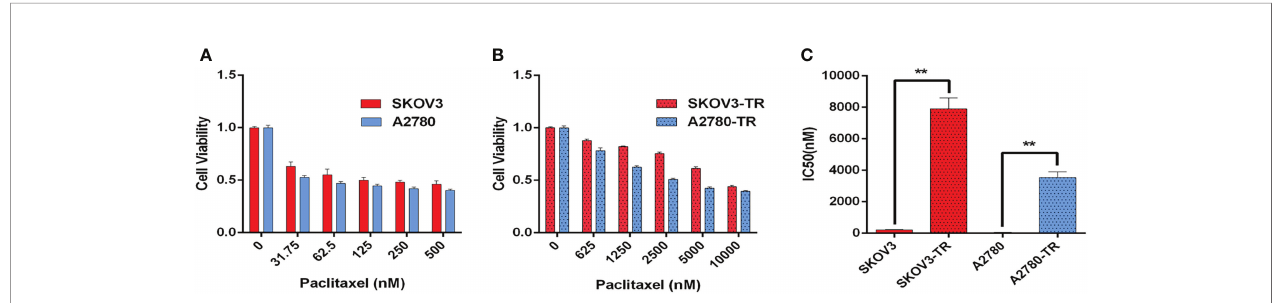
FIGURE 4 | Paclitaxel inhibits ovarian cancer cell viability. (A, B) Viability of paclitaxel-resistant (SKOV3-TR and A2780-TR) and paclitaxel-sensitive (SKOV3 and A2780) cell lines in response to different concentrations of paclitaxel measured by the CCK-8 assay. (C) IC 50 values of paclitaxel for SKOV3, A2780, SKOV3-TR, and A2780-TR cells. The IC 50 values are calculated by SPSS 19.0 software. (**p < 0.01, n = 3, student t-test, means ± 95%